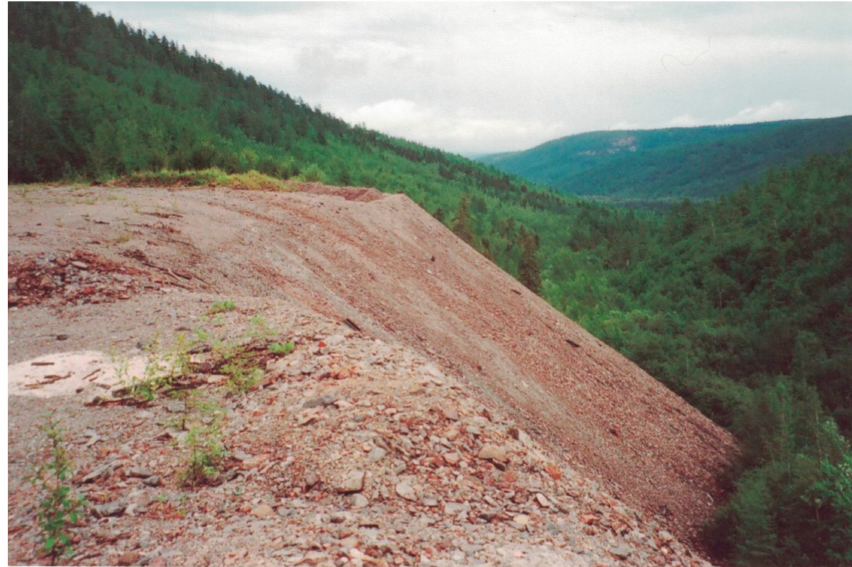
Figure 2. Dumps of radioactive rock at the Kurung site.